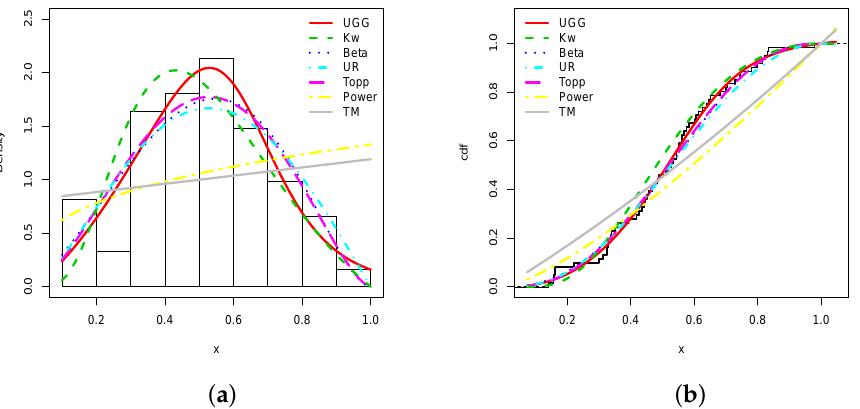
Figure 6. Plots of the ( a ) estimated pdfs and ( b ) estimated cdfs of the considered models and the trade share data set.